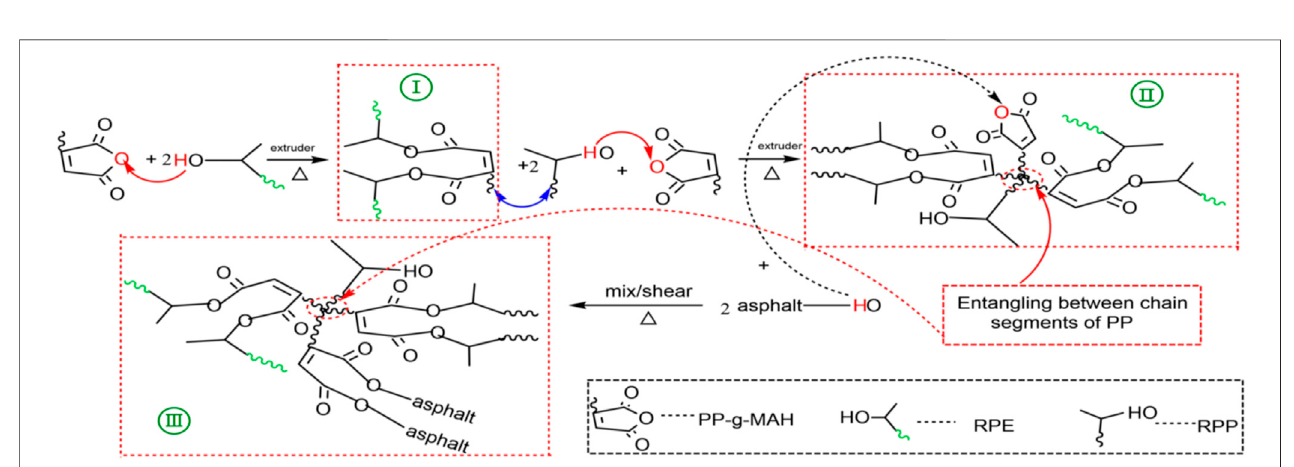
FIGURE 6 | The reaction mechanism of asphalt modi fi ed by